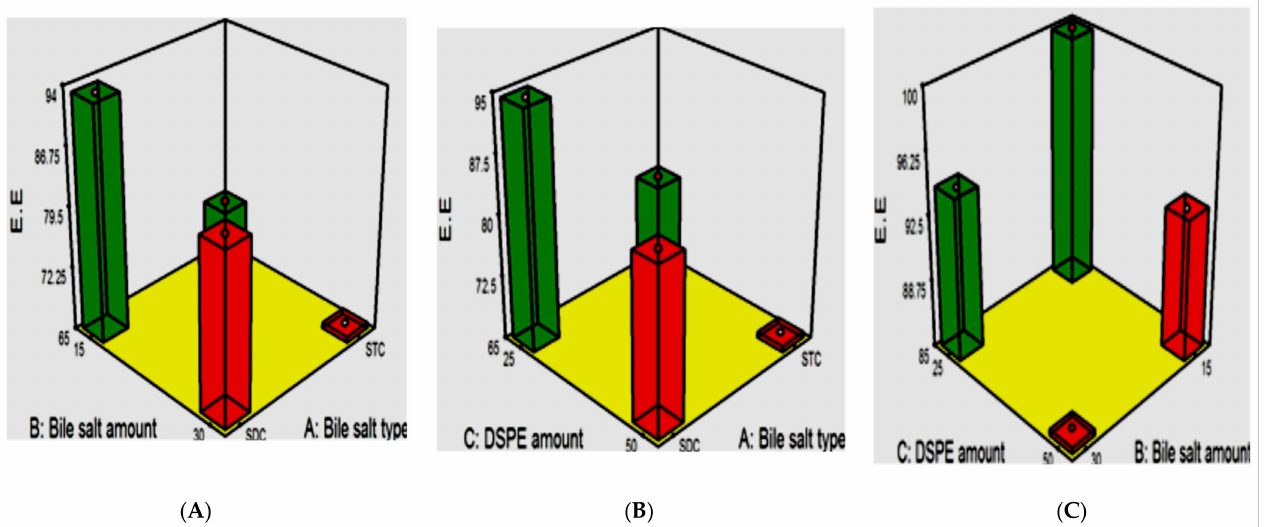
Figure 9. 3D surface response plots exploit the impact of ( A ) bile salt type, ( B ) bile salt amount and ( C ) DSPE–mPEG-2000 amount on EE% of 4e -loaded PEGylated